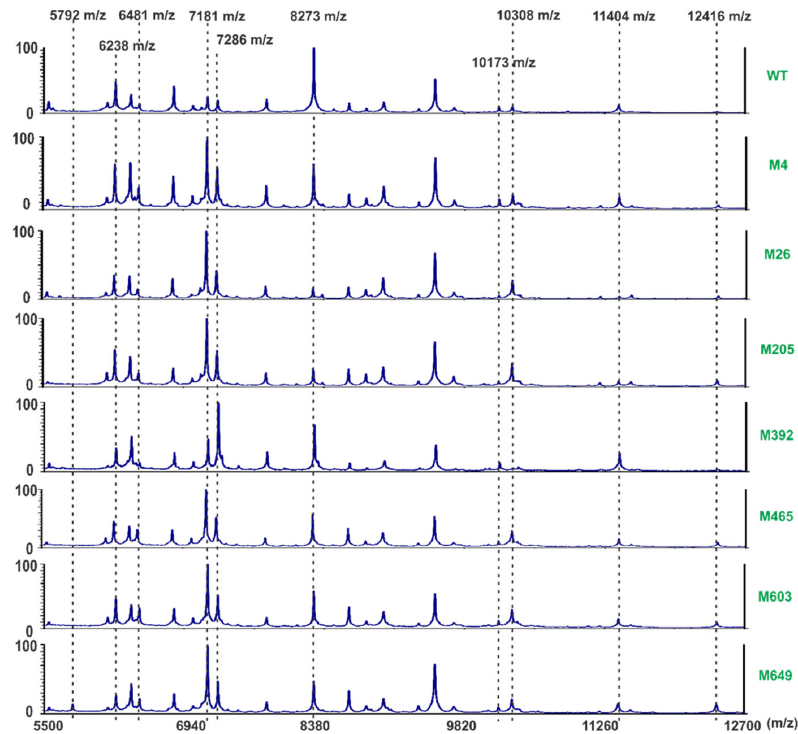
Figure 4. Representative MALDI ‐ TOF spectra of P. parmentieri wild ‐ type strain SCC 3193 and seven phage ‐ resistant mutants obtained with a sinapinic acid (SA) matrix. Averages from two independent biological replicates, each containing three technical replicates, are shown.